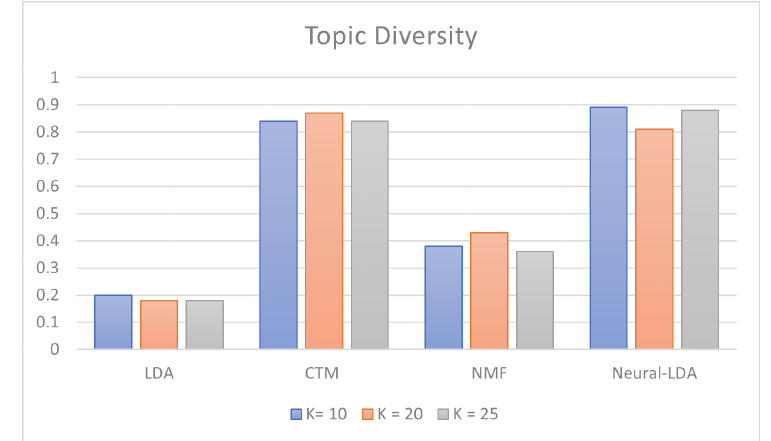
Figure 4. Topic Diversity Bar